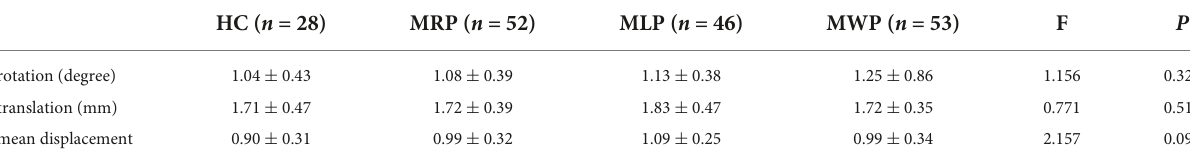
( Figure 3E ): right superior longitudinal fasciculus, right corona radiata, body of the corpus callosum, the right splenium of the corpus callosum, right cingulum (cingulate gyrus), right sagittal stratum (including the inferior longitudinal fasciculus and inferior fronto-occipital fasciculus), right posterior limb